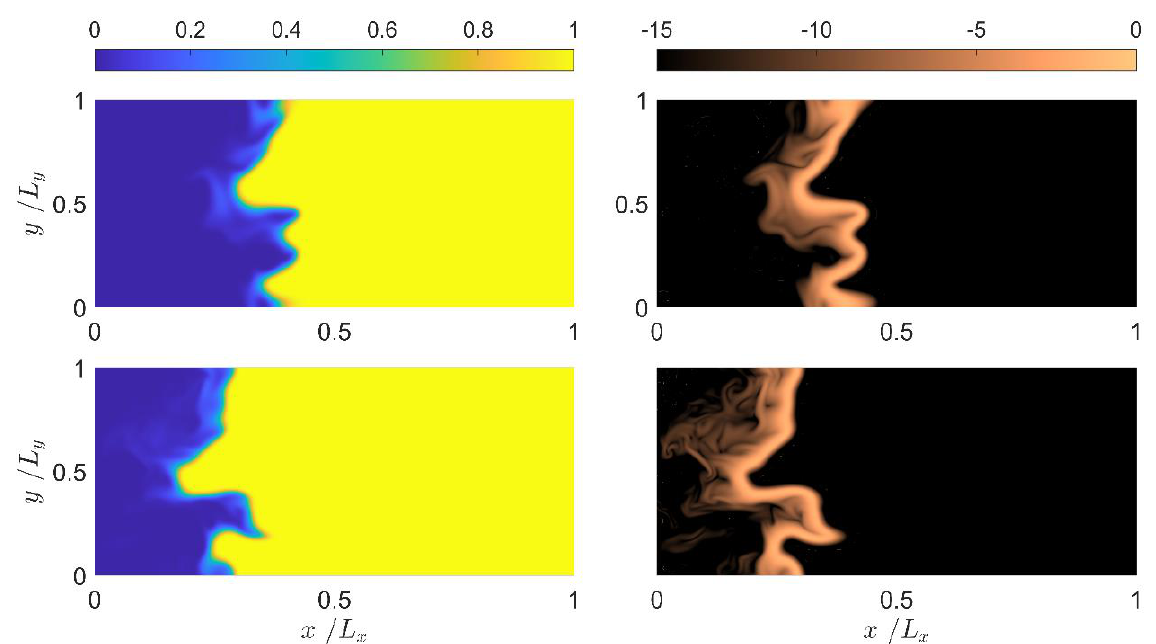
Figure 3. Spatial distributions of 𝑐 based on CH 4 mass fraction (1 st column) and the natural loga- rithm of its normalised SDR ln (𝑁 𝑐 × 𝑙 0 /𝑢 0′ ) (2 nd column) in the central midplane for the premixed combustion for initial 𝑢 ′ /𝑆 𝐿 = 4.0 (1 st row) and 8.0 (2 nd row).